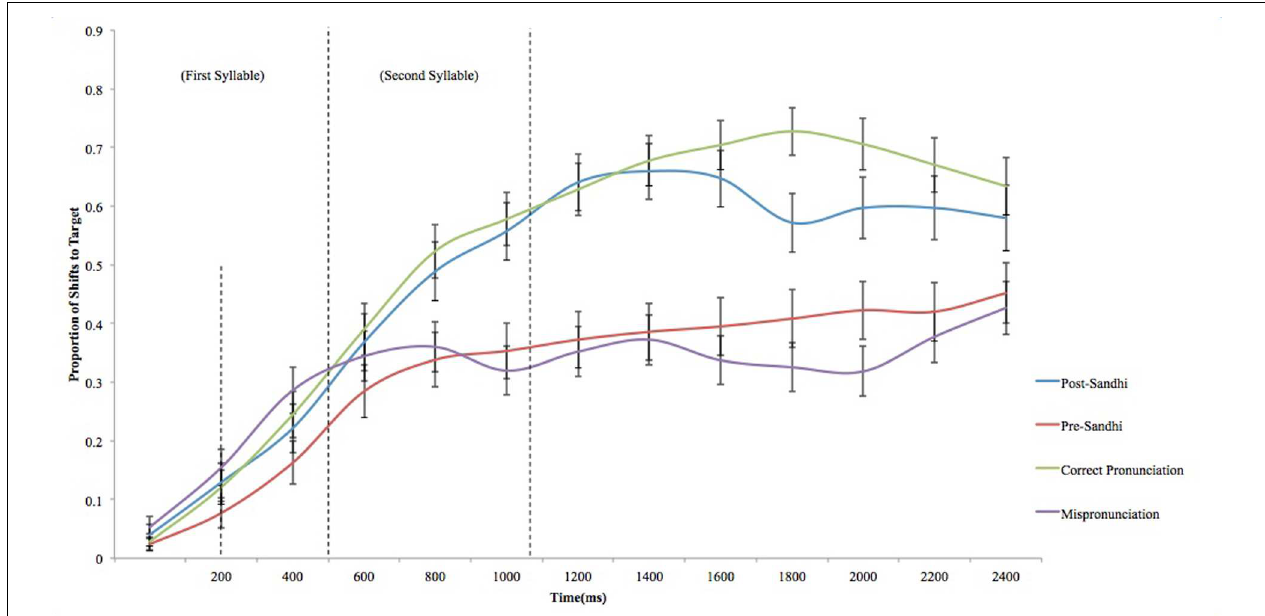
FIGURE 4 | Proportion of shifts to the target on distractor-first trials (Error bars reflect SEM). Dashed lines indicate offset of time allowance provided to launch an eye-movement, average offset of first syllable and average offset of second syllable respectively.